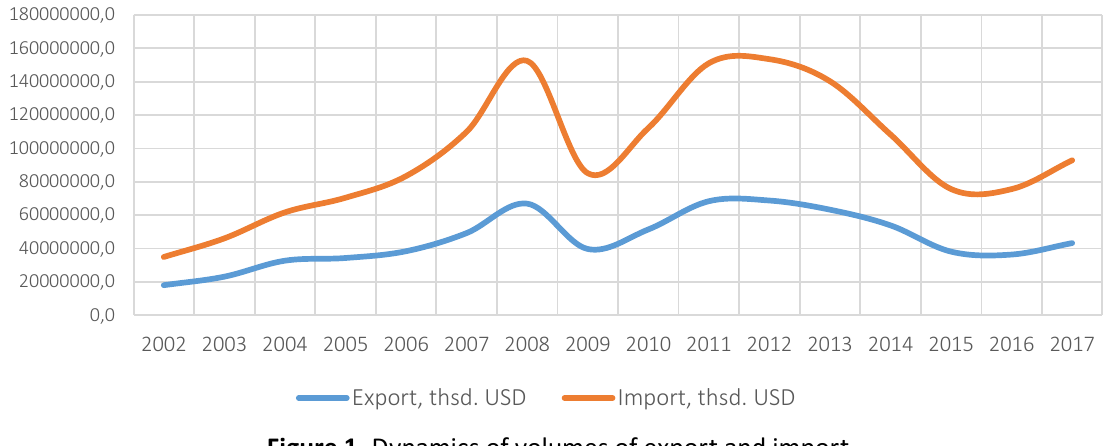
Figure 1. Dynamics of volumes of export and